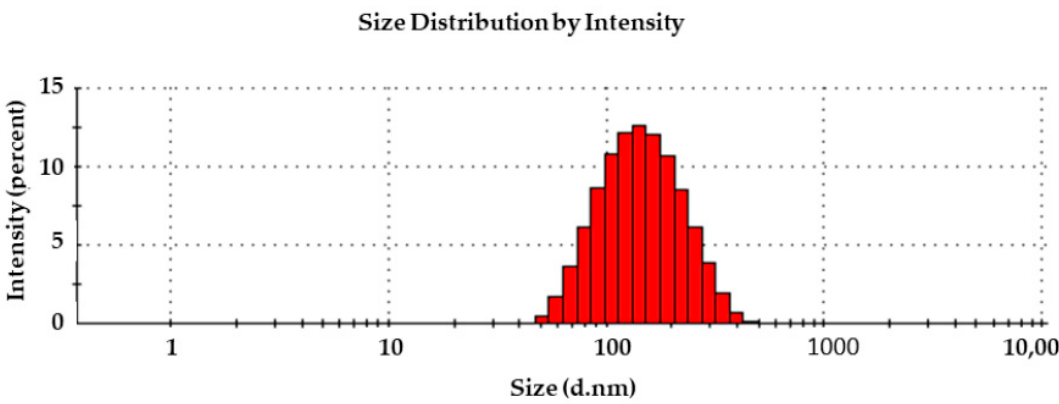
Figure 1. Size measurement of rutin-quercetin NPs (RQ-NPs) using dynamic light scattering (DLS). Average particle size is around 200 nm in diameter: Polydispersity index (PDI) = 0.169.